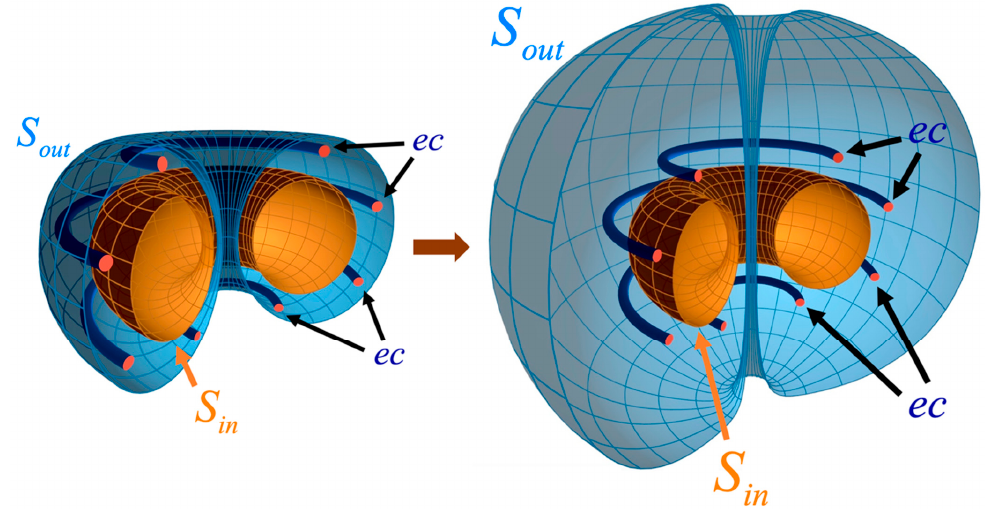
Figure 3. Surfaces of integration in (40), the inner S in and the outer S out ones. On the right plot, the S out torus is transformed into a sphere with a disappearing hole at r = 0. As in Figure 1, ec means external coils .